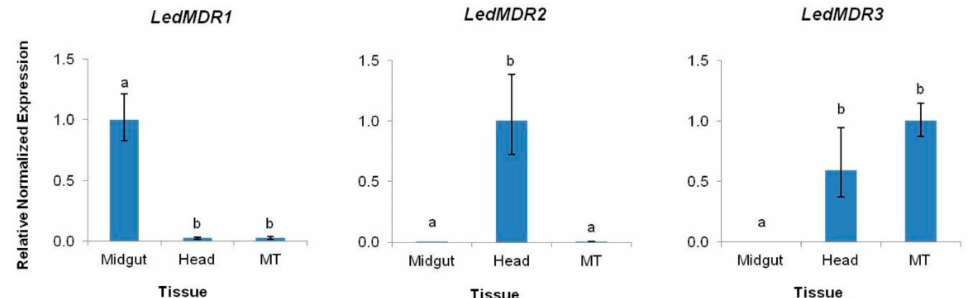
Figure 1. Expression levels of LedMDR1 , LedMDR2 , and LedMDR3 in the midgut, head, and Malpighian tubules (MT) tissues of adult L. decemlineata . Bars represent the mean normalized fold change of each gene ( ± SEM, n = 3) relative to the tissue in which each gene is most highly expressed. Di ff erent letters represent significantly di ff erent expression levels (Tukey’s Honestly Significant Di ff erence (HSD), p < 0.05).